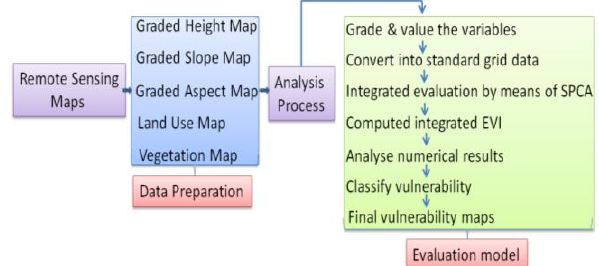
Figure 3. Schematic representation of numerical model of environmental vulnerability evaluation by means of spatial principal component analysis.